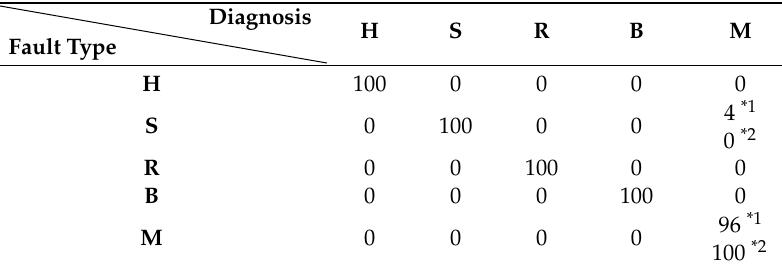
Table 5. FDA results classification accuracy (%).